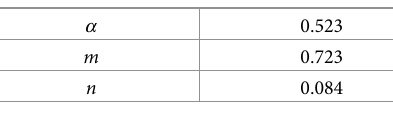
Table 2. The fitted values of coefficients m and n